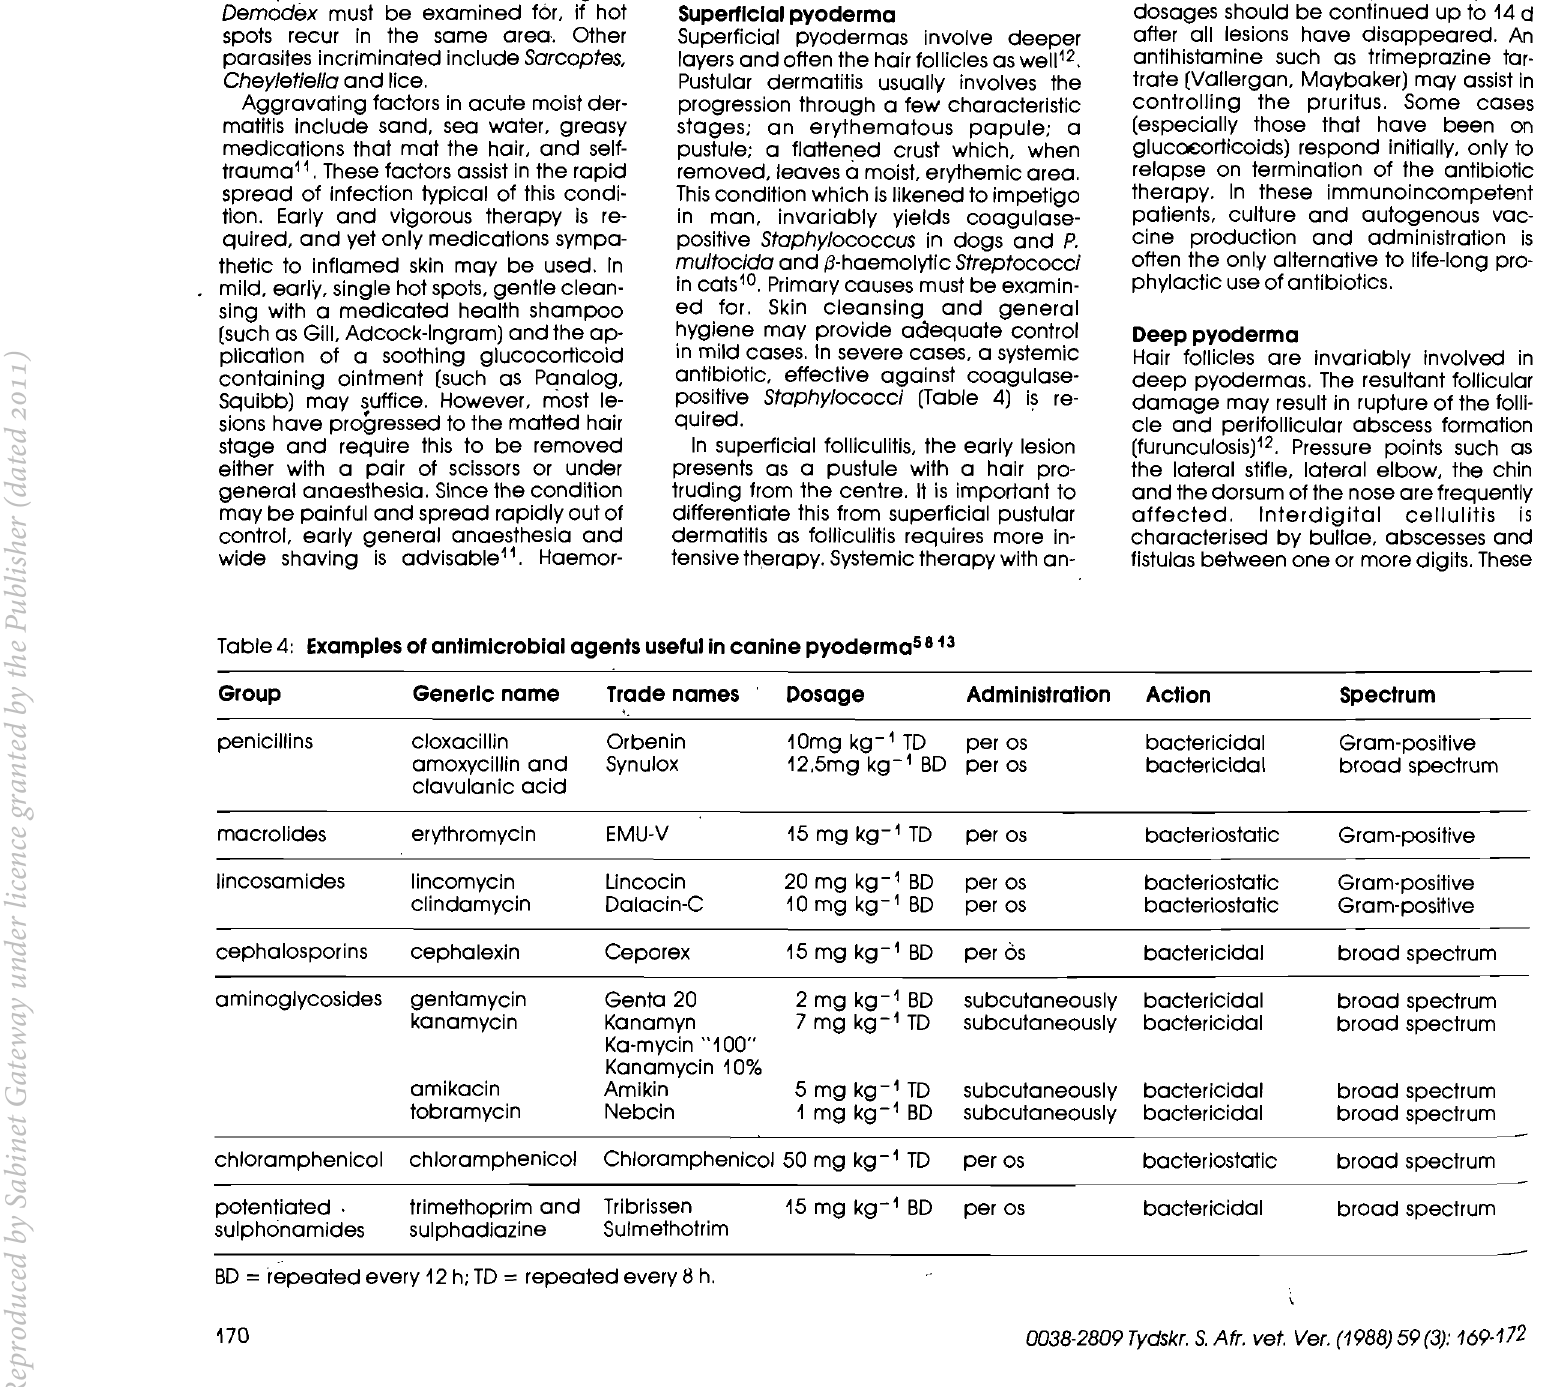
Table 4: Examples of antimicrobial agents useful in canine pyoderma 5813